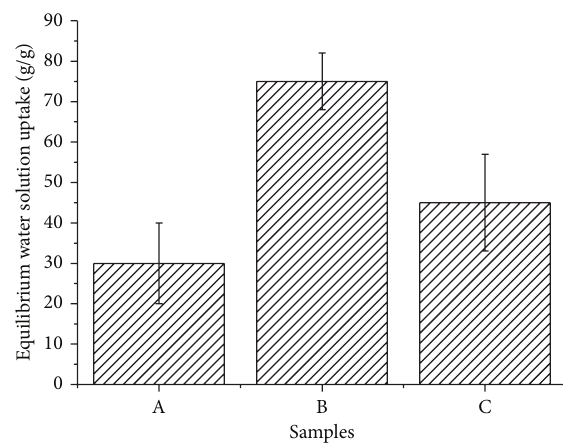
Figure 2: Hydrogel equilibrium swelling properties in distilled water.Resultsarereportedasmean ± standarddeviationofthemean ( 𝑛 = 5